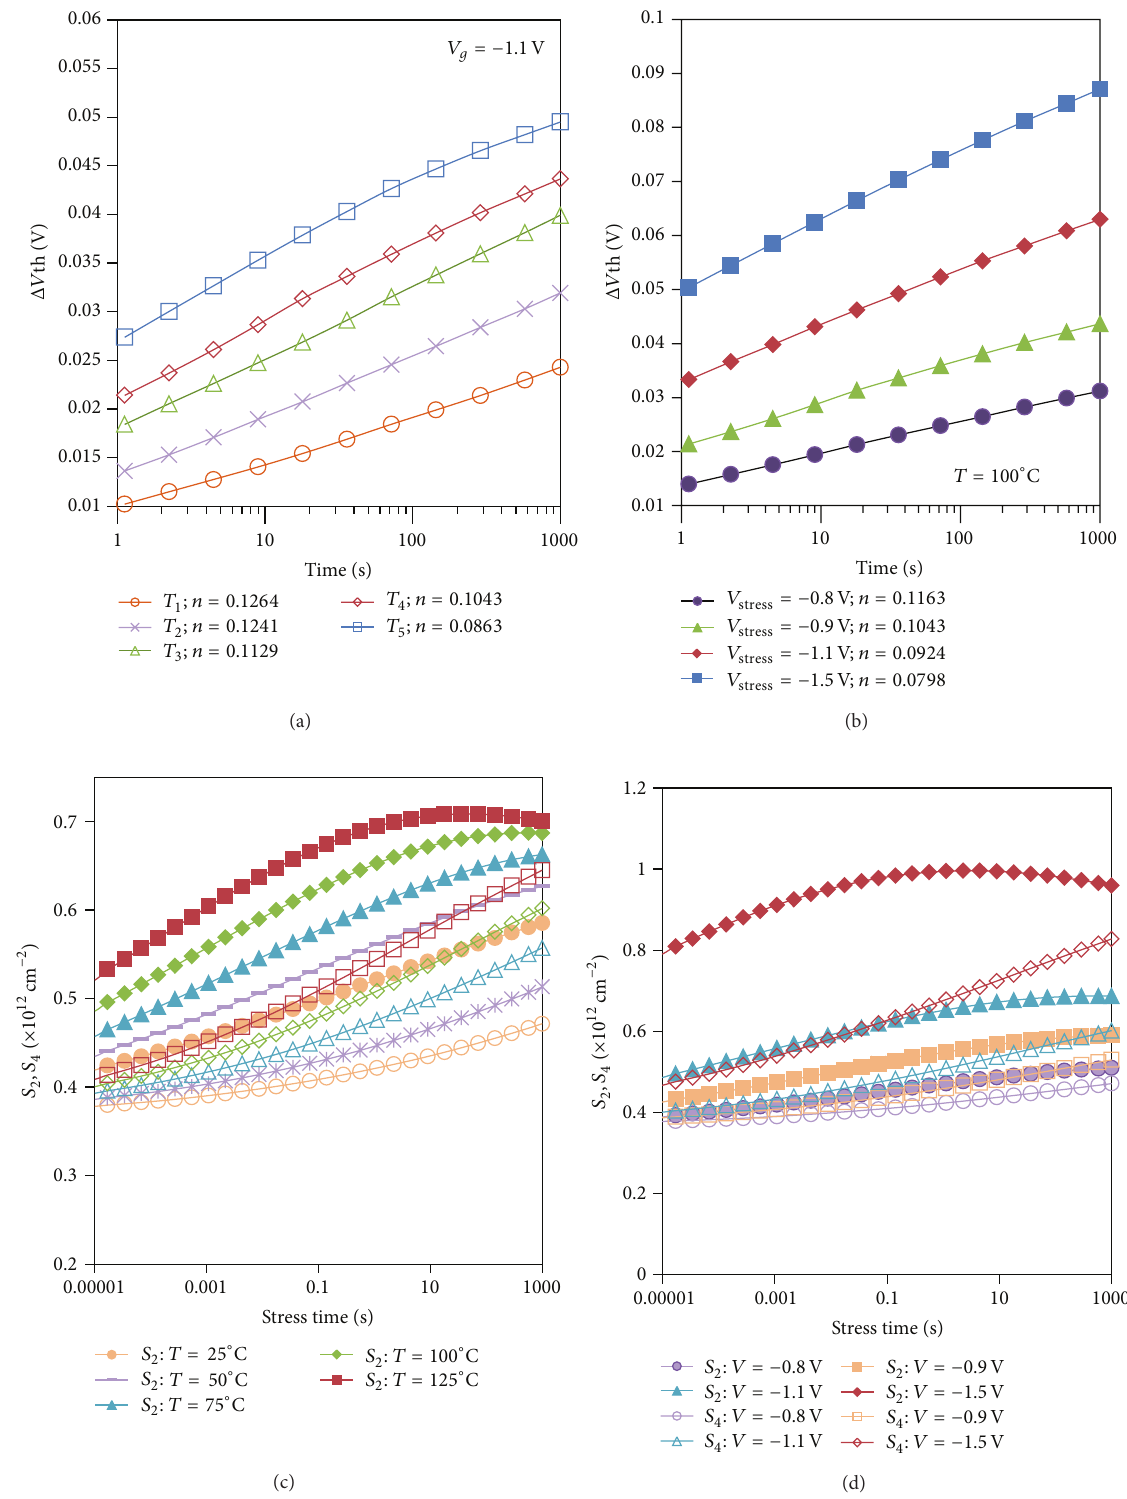
Figure 5: Threshold voltage shift as a function of stress time at (a) different stress temperatures and (b) different stress gate voltages. Hole trap density, 𝑆 2 , and interface trap density, 𝑆 4 , as a function of stress time at (c) different stress temperatures and (d) different stress gate